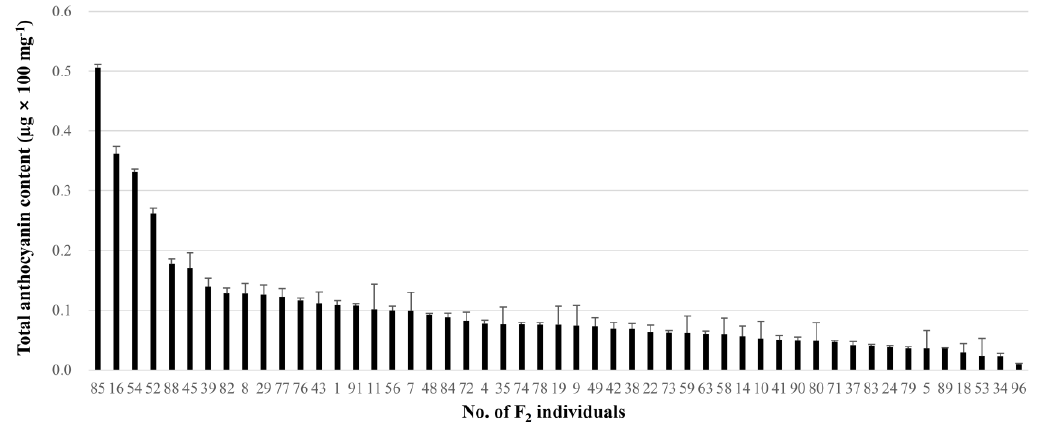
Figure 4. Total anthocyanin content of 51 red bulbs in the F 2 population of SP3B×H6.